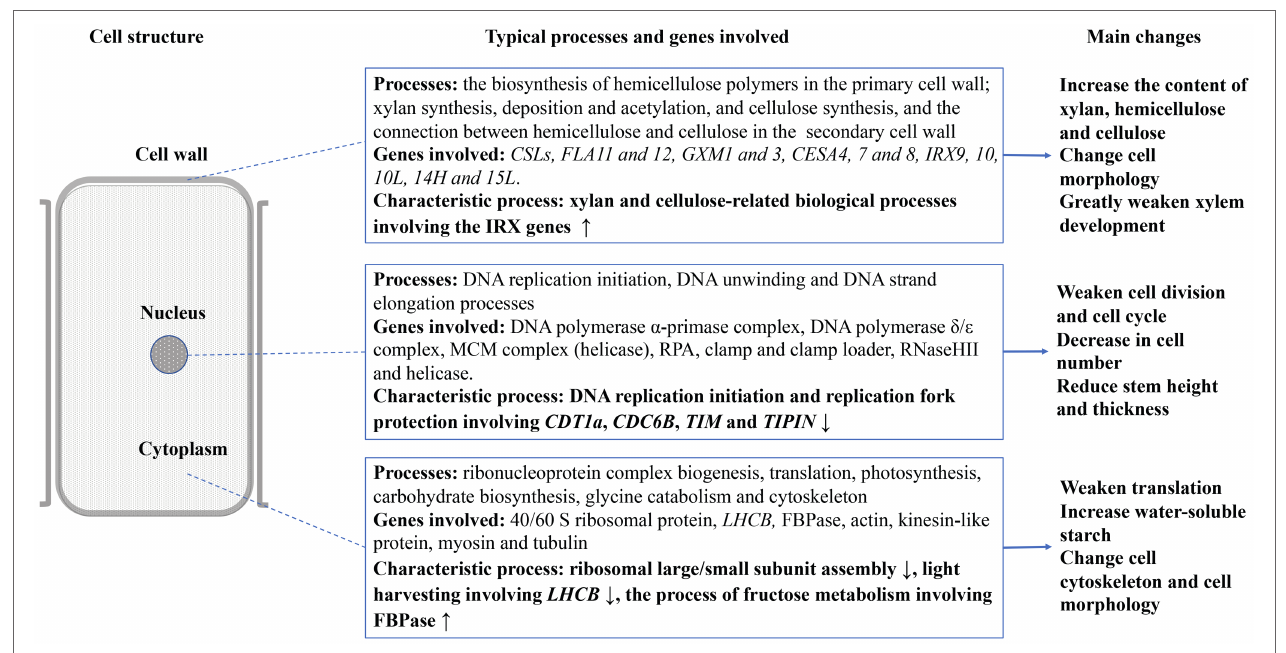
FIGURE 4 | Overview of effects on stem development in JcFT OE plants ( ↑ and ↓ denote up- and down-regulated expression, respectively).